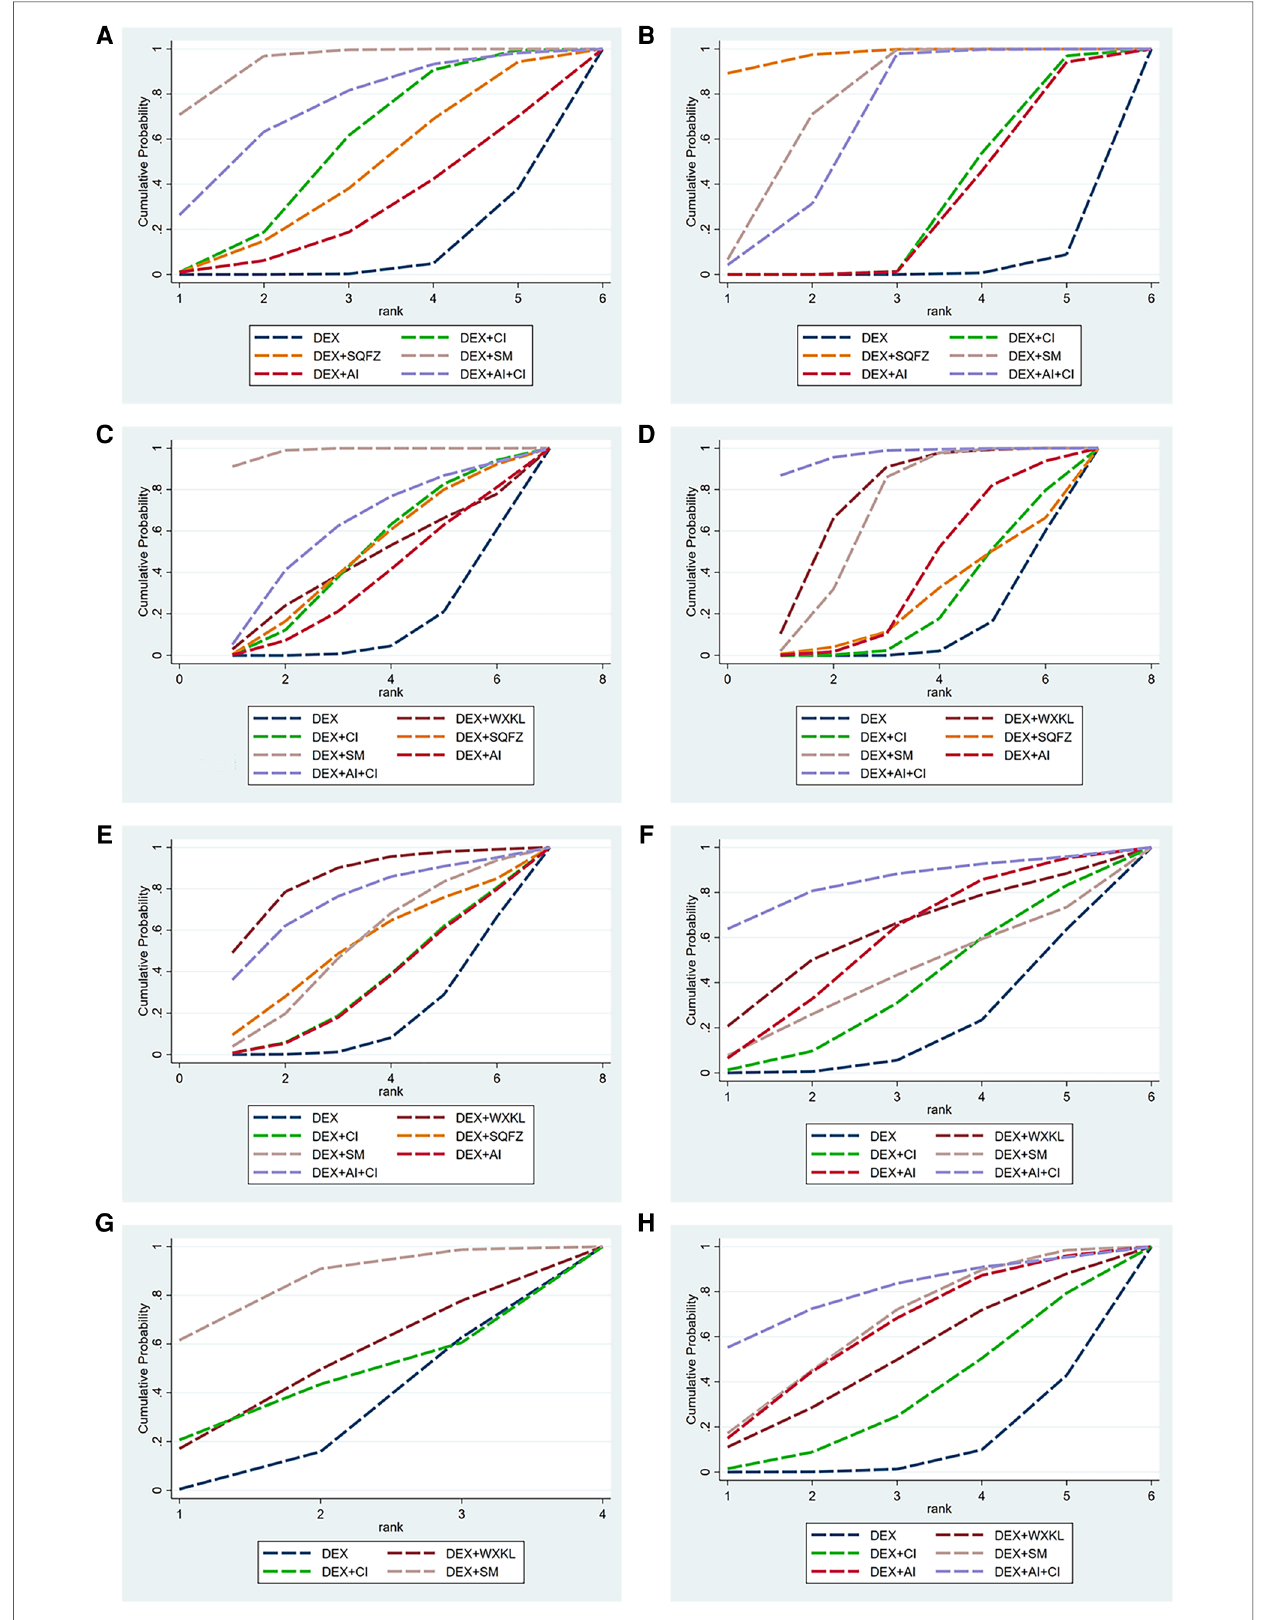
FIGURE 5 The surface under the cumulative ranking curve (SUCRA) is shown for each treatment. ( A ) cTnI. ( B ) CK-MB. ( C ) LVEF. ( D ) Rate of abnormal of ECG. ( E ) ST-T change abnormal. ( F ) Sinus tachycardia. ( G ) Atrioventricular block. ( H ) Premature beat (DEX, Dexrazoxane; DEX+WXKL, Dexrazoxane combined with Wenxinkeli; DEX+CI, Dexrazoxane combined with Cinobufotalin injection; DEX+SQFZ, Dexrazoxane combined with Shenqifuzheng injection; DEX+ SM, Dexrazoxane combined with Shenmai injection; DEX+AI, Dexrazoxane combined with Astragalus injection; DEX+AI+CI, Dexrazoxane combined with Astragalus with Cinobufotalin